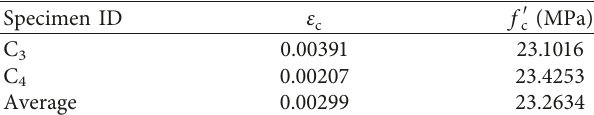
universal recorder; (cid:31)